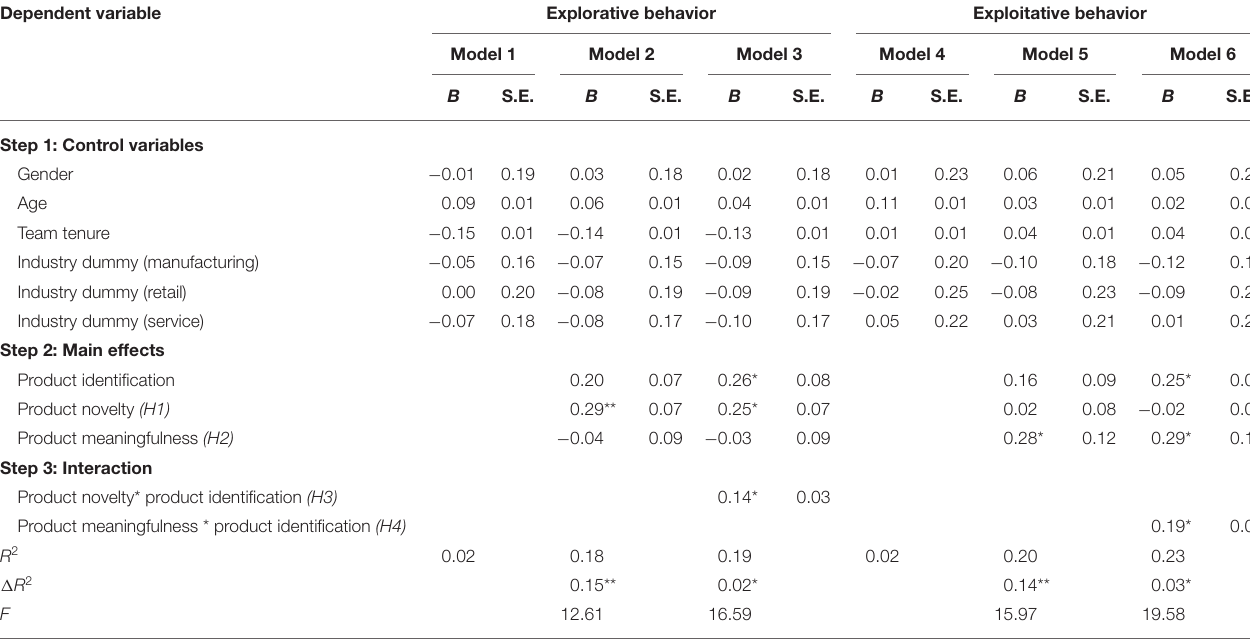
TABLE 2 | Results of hierarchical regression analyses by product